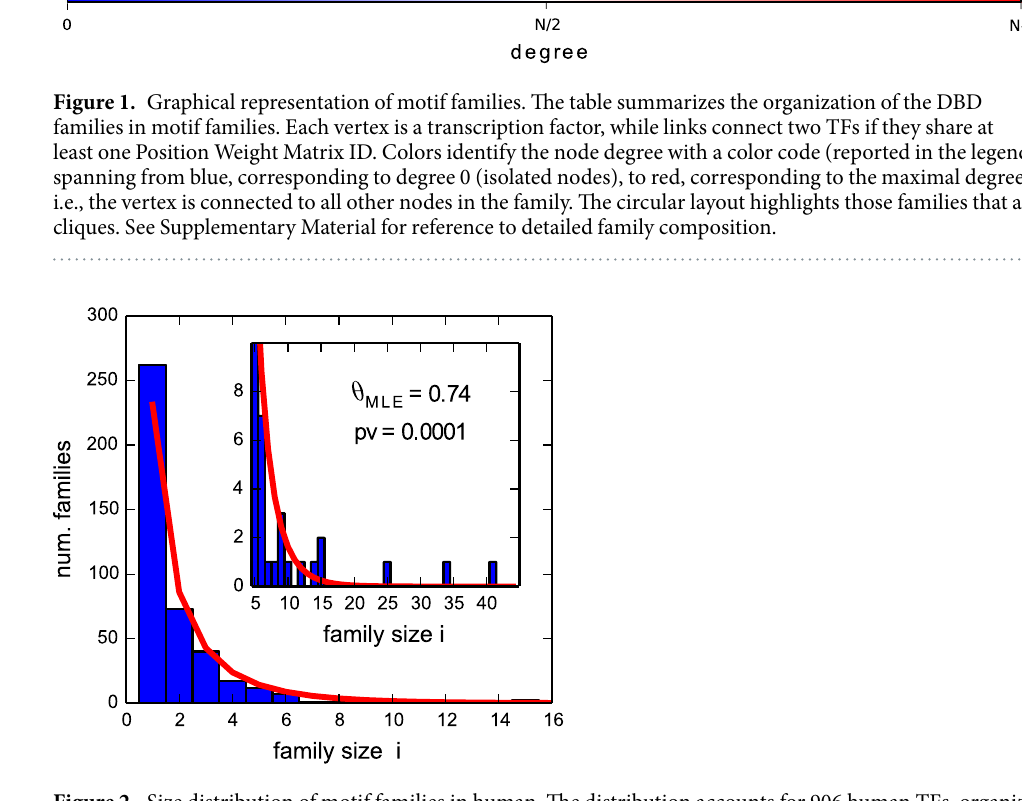
The Birth-Death- cis- Innovation model. The model we propose belongs to the general class of Birth-Death-Innovation models (for a thorough introduction see ref. 30). The focus of these models is on sys- tems in which individual elements are grouped into families whose evolution is ruled by the dynamics of their